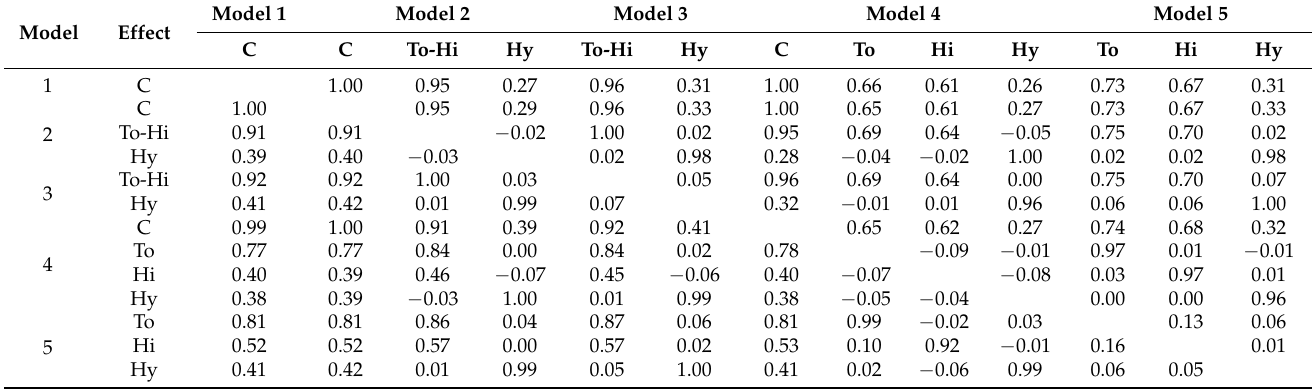
Table 3. Pearson correlation coefficients of allele substitution effects of single nucleotide polymor- phism (SNP) markers for cold carcass weight and marbling score (above and below diagonals, respectively) 1